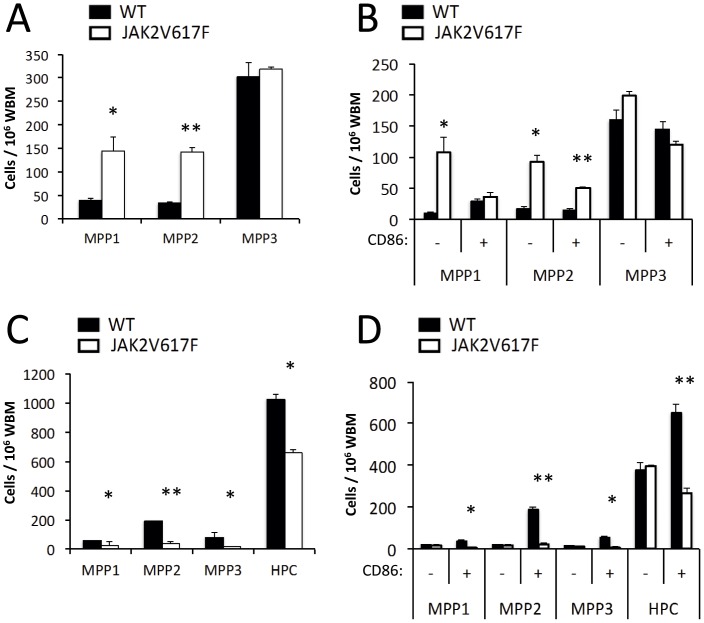
Multipotent progenitors are altered in JAK2V617F Tg mice.(A) LSK from control and Tg mice were resolved with CD150, CD48, Flk2 and CD34 staining into MPP subsets as described by Trumpp and colleagues [45]. The subset definitions are CD150+ CD48− CD34+ LSK (MPP1), CD150+ CD48+ CD34+ LSK (MPP2) and CD150− CD48+ CD34+ LSK (MPP3). (B) These populations were further subdivided on the basis of CD86 expression. (C) Morrison and colleagues exploited CD150, CD48, CD229 and CD244 to define MPP subsets [46], and (D) again we subdivided them on the basis of CD86 display. The surface markers define CD150− CD48− CD229− CD244− (MPP1), CD150− CD48− CD229+ CD244− (MPP2), CD150− CD48− CD229+ CD244+ (MPP3), and CD150− CD48+ (HPC). The results are given as the percentages of BM cells and are representative of those obtained in two independent experiments (N = 3). Despite the common nomenclature used with these methods, distinct subsets and possibly separate differentiation pathways are identified (See Figure 8).